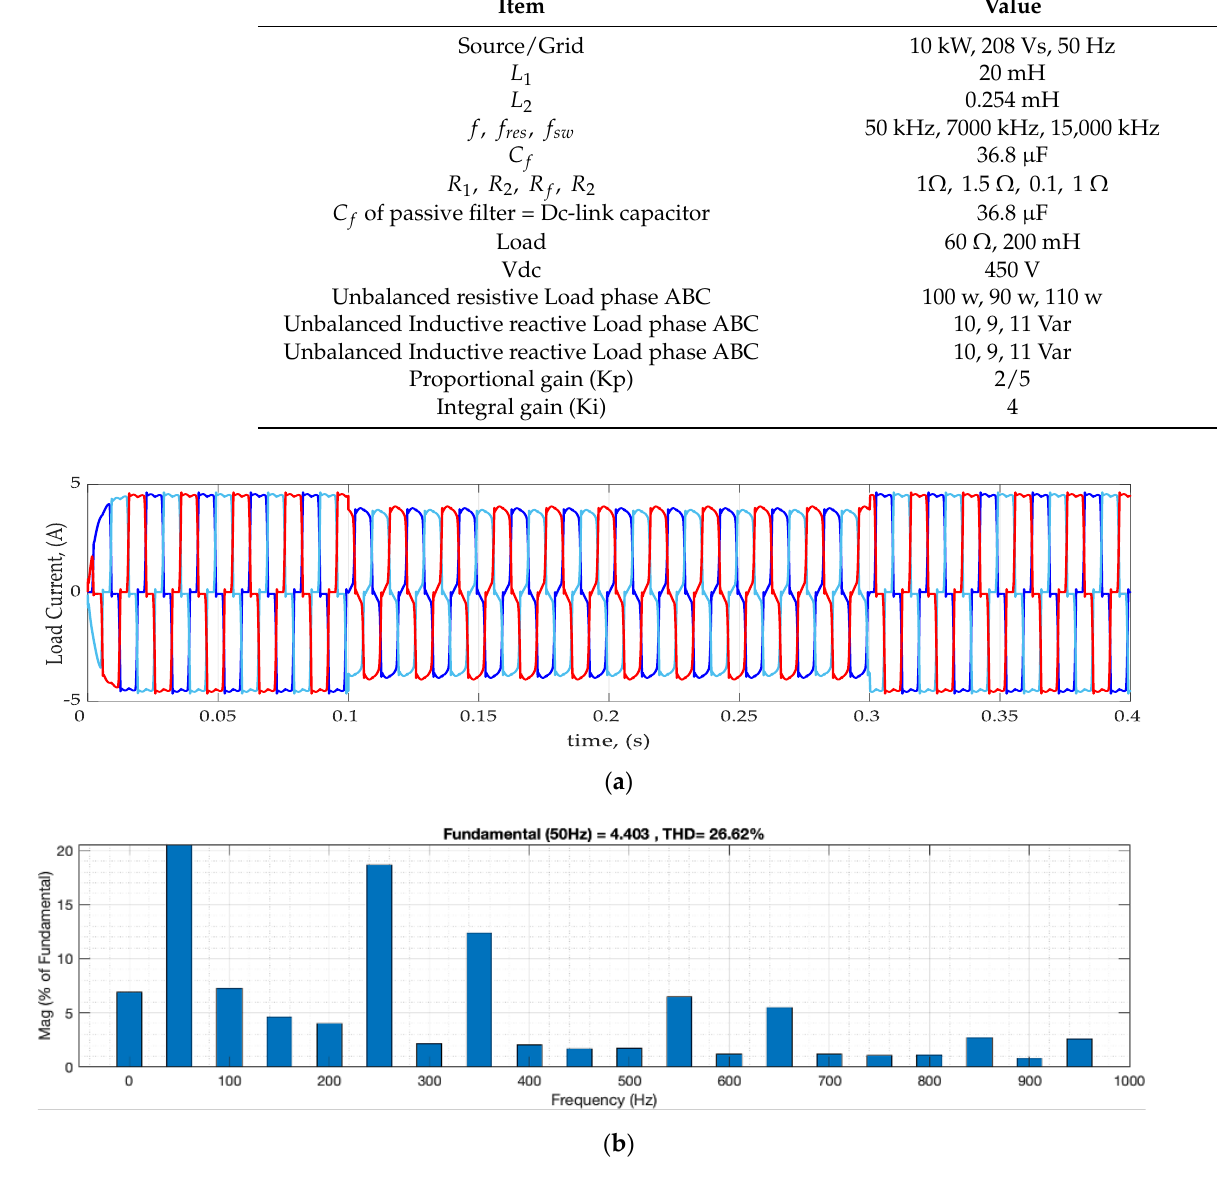
Figure 6. Load current and THD ( a ) variable load current wave shape and ( b ) system THD prior to